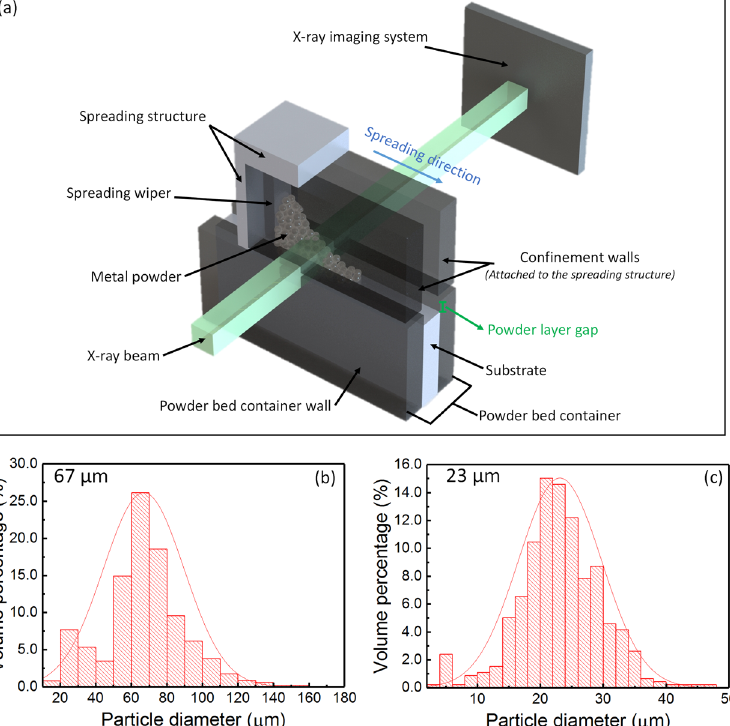
Figure 1. Schematic of the experimental set-up and particle size distributions of 316 L stainless steel powders. ( a ) Schematic of the experimental set-up for in-situ powder spreading high-speed x-ray imaging. ( b , c ) Powder size distributions for stainless steel powders with average particle diameters of 67 µ m ( b ) and 23 µ m ( c ). The experiments were carried out at the beamline 32-ID-B of the Advance Photon Source. The experiments were run under an ambient pressure of 1 atm. A rigid aluminum blade with a flat front was used as a wiper. Two rectangular confinement walls were attached to the spreading structure to prevent powders from flowing into path of the x-ray beam. The two powder bed container walls were made of high density graphite to ensure x-ray transparence, low friction and absence of static electric charge accumulation. The powder was spread over an aluminum substrate which was lowered through a z-axis motion stage to create the powder layer gap.